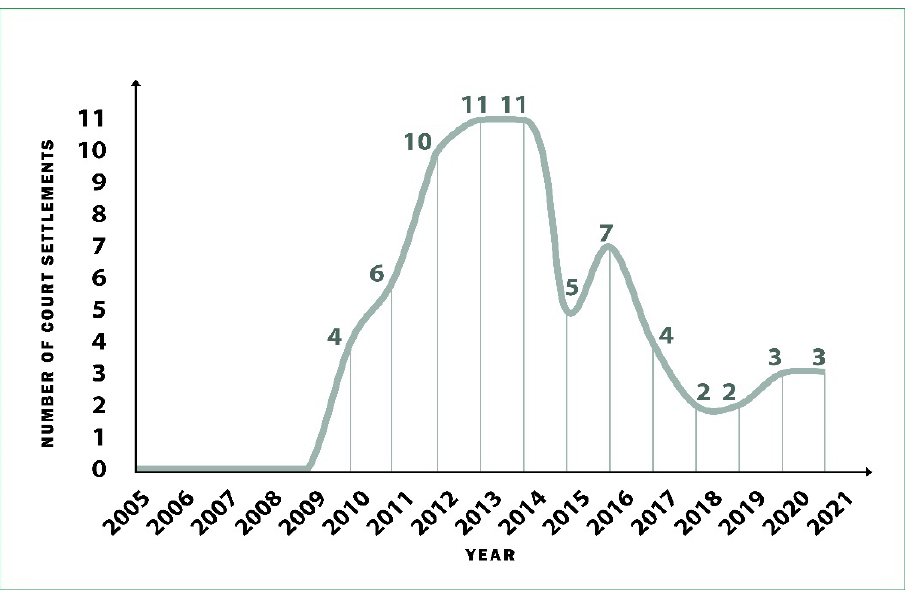
Figure 4. Number of decisions on spatial plans and wind power plants between 2005 and 2021. Source: own elaboration.